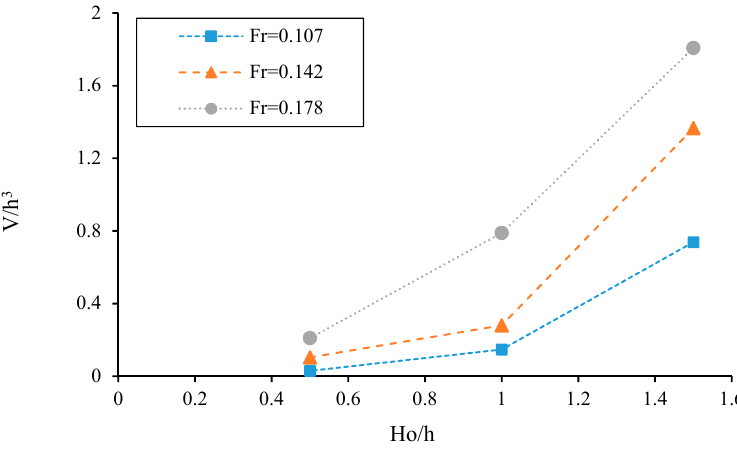
Figure 4. Comparison of the height of W-weir for θ = 64°.